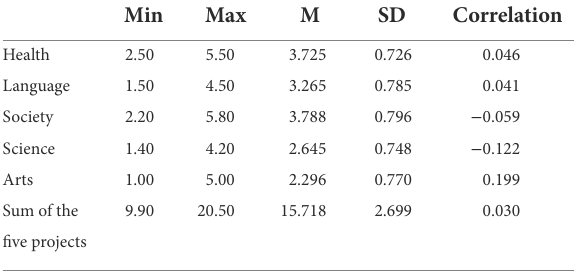
(1) Results of the Null Model According to the null model results (see Table 5), the ICC values of PPVT and REMA-SF were obtained as 0.604 and 0.545, respectively. Depending on the value of ICC was greater than 0.138, it was necessary to use MLM to analysis the data (Cohen et al., 1990). The analytical results of Model I were shown in Table 5 (Model I column). It can be seen from the table that gender had a significant predictive effect on children’s REMA-SF , but not on PPVT ; Age had a significant predictive effect on PPVT and REMA-SF development in children. According to the S&B (Snnijders & Bosker) method, the proportion of variance explained by individual-level predictors was calculated (Snijders and Bosker 1994, 2011). As shown in Table 5, individual-level predictors (gender and age) explained 47.9% of the variance variation of PPVT in children, 40.5% of the variance variation in children’s REMA-SF . The model fit indices showed a decrease in deviance. The analytical results of Model II were shown in Table 5 (Model II column). It can be seen from the table that teachers’ cognitive sensitivity did not have a significant predictive effect on PPVT and REMA-SF development in children. The S&B method was also used to calculate the proportion of variance explained by adding class-level predictive variables (see Table 5). At this time, the variance variation explained by the cognitive sensitivity of teachers at the class level for children’s PPVT was 73.8%; the variance variation interpreted for children’s REMA-SF was 63.1%. Compared with the variation explained by Model I, there was an increase. The results of model fit indices appeared that the value of deviance barely changed from Model I to Model II.